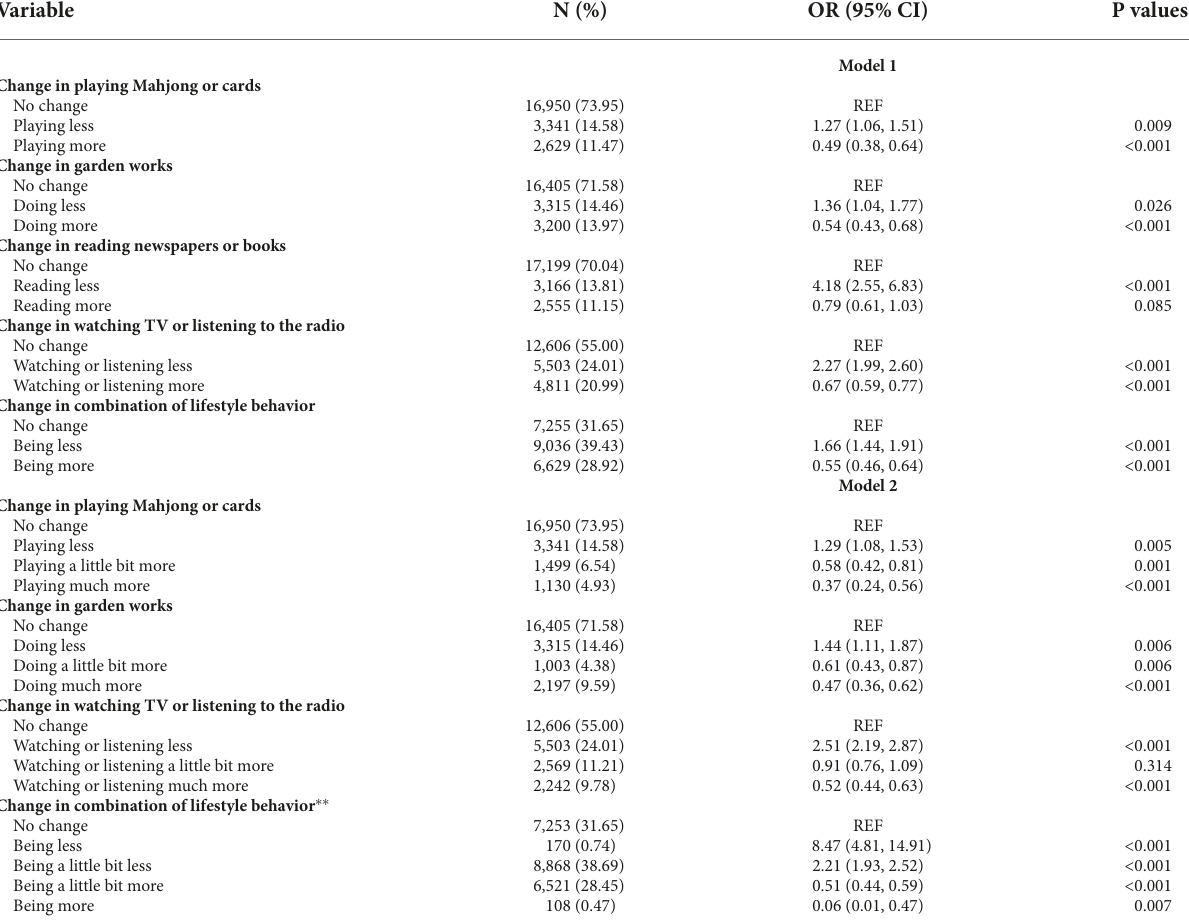
TABLE 4 The association of lifestyle change with cognitive impairment. ∗